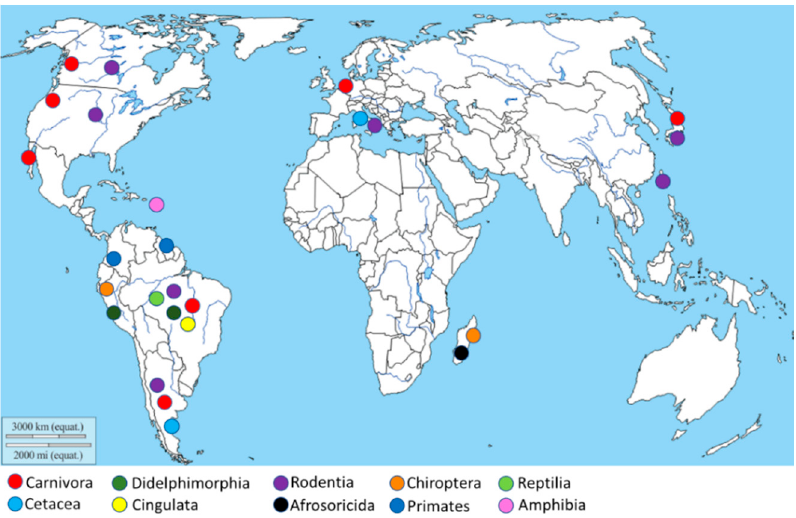
Figure 2. Geographical distribution of the Leptospira isolation. The map shows, through different colors, Leptospira isolation from different animal orders.